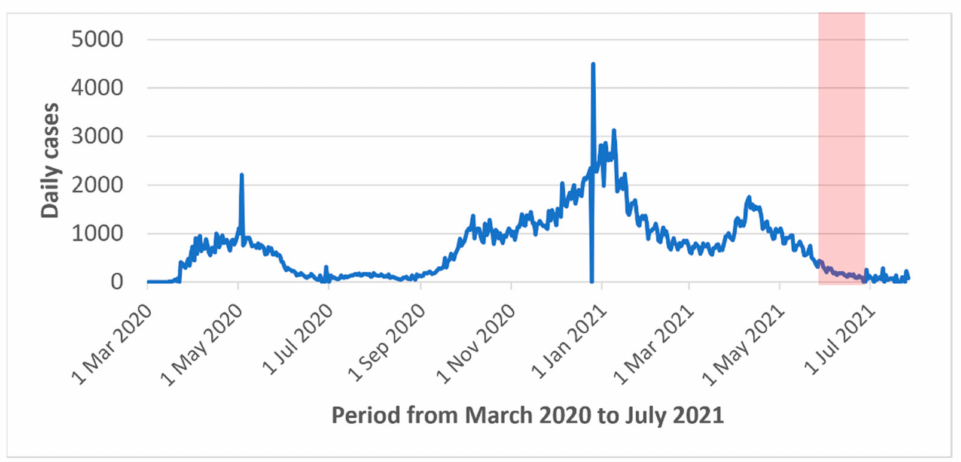
Figure 1. Daily new cases of COVID-19 in the province of Qu é bec and the data collection period (in red). Data from the Government of Canada